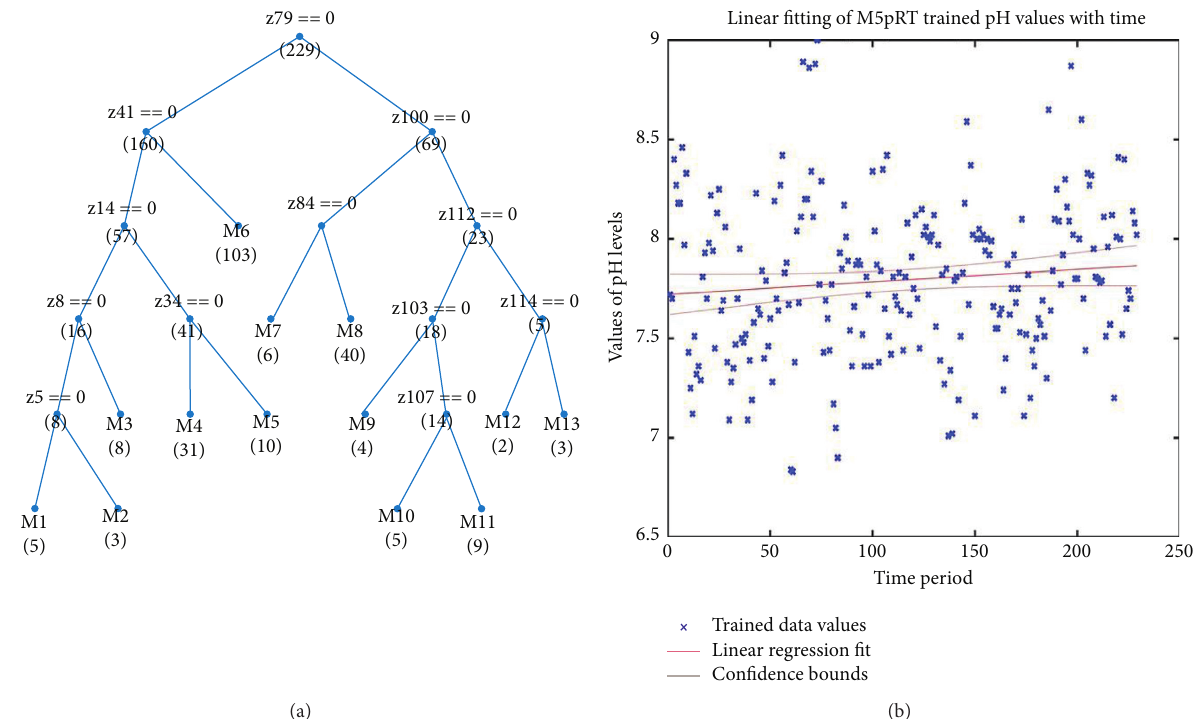
Figure 8: (a) Regression tree simulated via M5pRT at Palla. (b) Linear regression fit of M5pRT trained pH data at